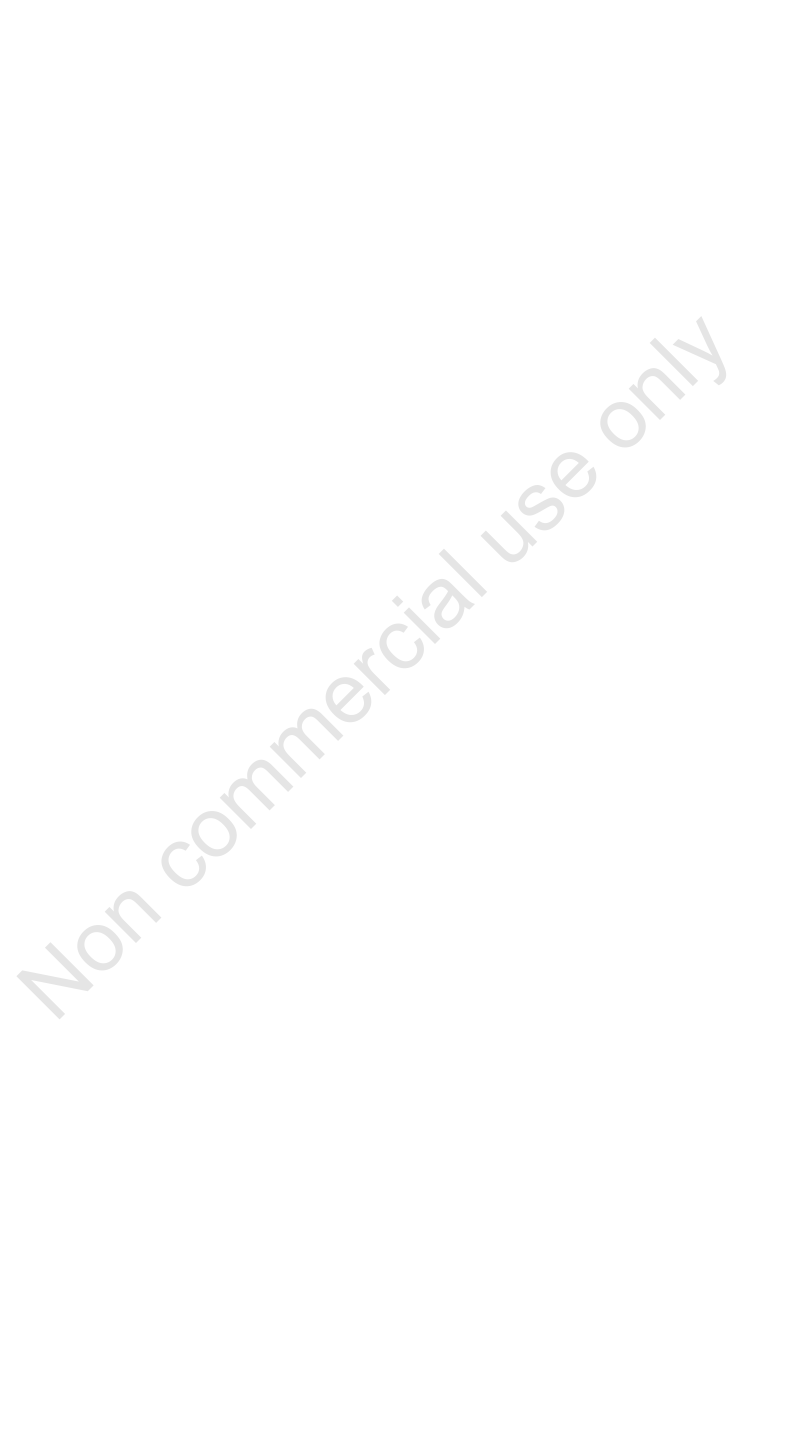
Summary Table. Update